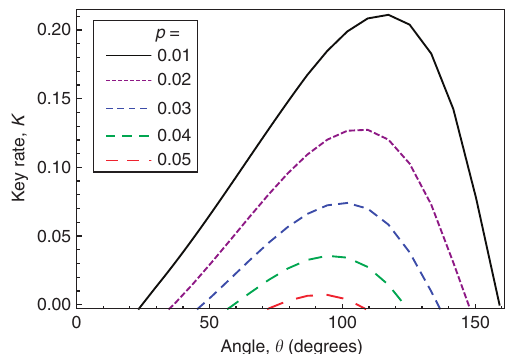
Figure 6 | The B92 protocol. The key rate (in bits per photon sent by Ailce) is plotted versus the Bloch-sphere angle between the two signal states. Curves are shown for various values of the depolarizing probability p